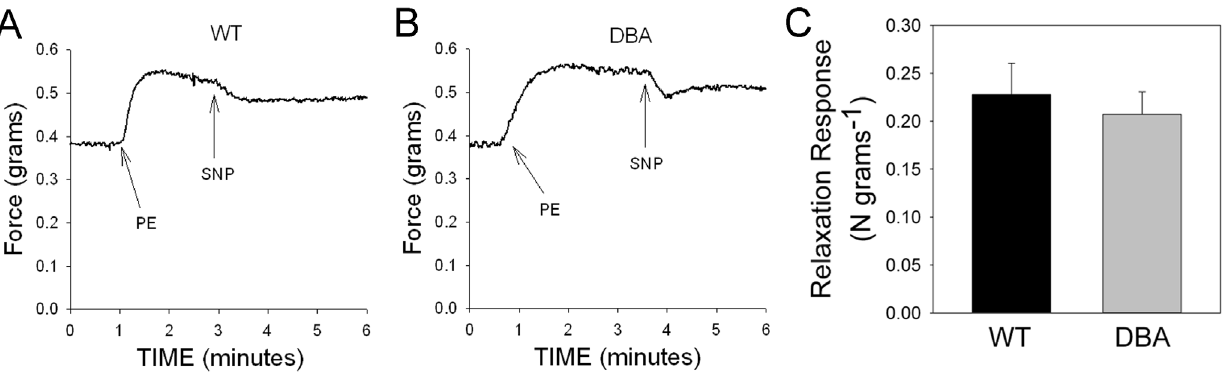
Figure 7. Effect of NO donor on contractile response in CCP. Representative tracing showing relaxation of cavernosal smooth muscle induced by SNP (1 m M) in WT (A) and DBA (B) mice after pre-contraction with phenylephrine (PE, arrow). (C) Graph compares the magnitude of SNP induced relaxation in WT (black circles) and DBA (gray triangles) mice. [n=9 for WT and n=10 for DBA cavernosal tissues, p=0.302, unpaired t-test].